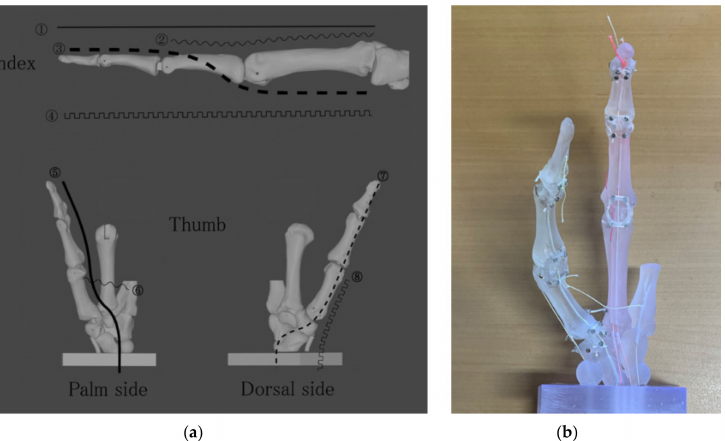
Figure 5. Trajectory of tendon sheath designed on the phalange model: ( a ) For the index, (1), (2) extensor digitorum, (3) flexor digitorum profundus, and (4) interosseous and lumbricals are designed. For the thumb, (5) flexor pollicis longus, (6) adductor pollicis, (7) extensor pollicis longus, and (8) abductor pollicis longus; ( b ) Prototype of the biomimetic